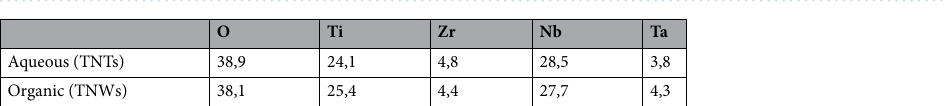
Table 3. Element composition (wt. %) obtained by XPS analysis of the TNTs (anodization with the aqueous electrolyte) and TNWs (anodization with the organic electrolyte).